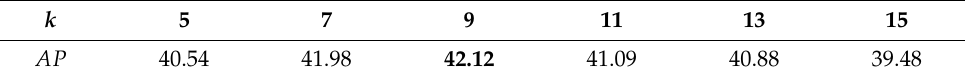
Table 3. Table analysis of different values of hyper-parameter k on the Visdrone2020 car class.